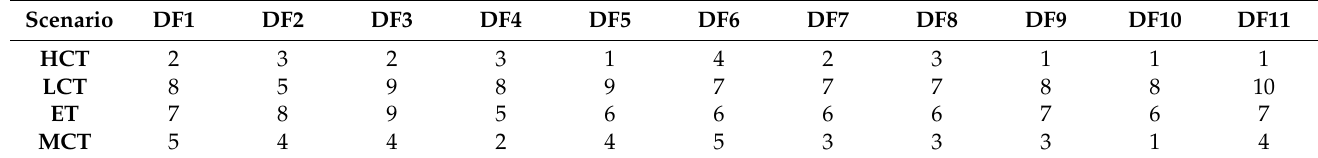
Table 3. Assessment matrix of tourism development scenarios.